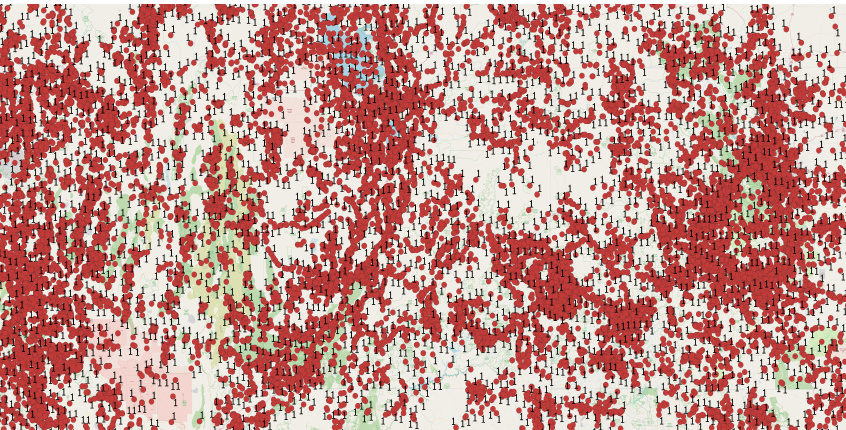
Figure 12. The visualization of a single cluster with cluster ID 1, which is the highly dense region, United States as per the MRDS dataset.